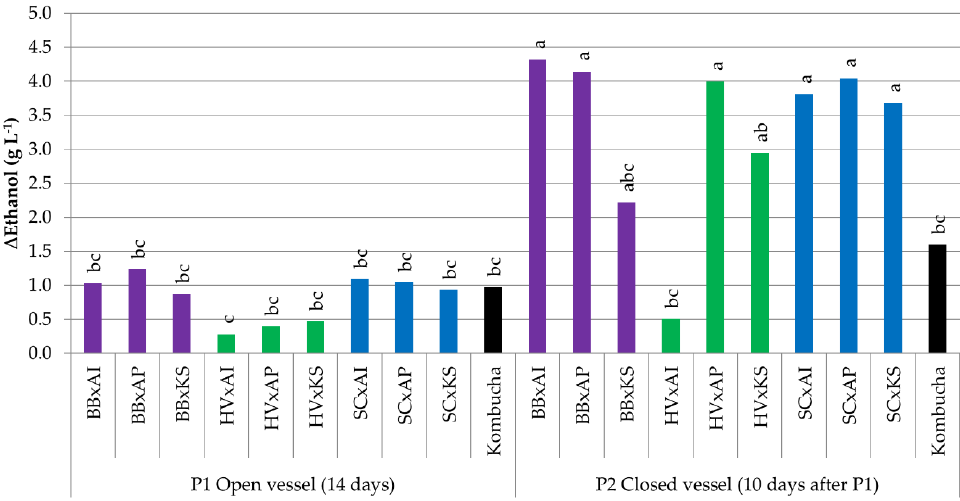
Figure 5. Difference in ethanol (g L − 1 ) of samples between day 0 (after inoculation) and the end point (14 days for pure cultures, 14 days in an open vessel for P1, and 10 days in a closed vessel for P2 following P1). ANOVA was performed with α = 0.05 and n = 3. Common letters imply non-significant differences between means. Colors reflect the yeast species in the coculture. BB = Brettanomyces bruxellensis (purple), HV = Hanseniaspora valbyensis (green), SC = Saccharomyces cerevisiae (blue), AI = Acetobacter indonesiensis , AP = Acetobacter papayae , KS = Komagataeibacter saccharivorans, and “x” = a coculture.